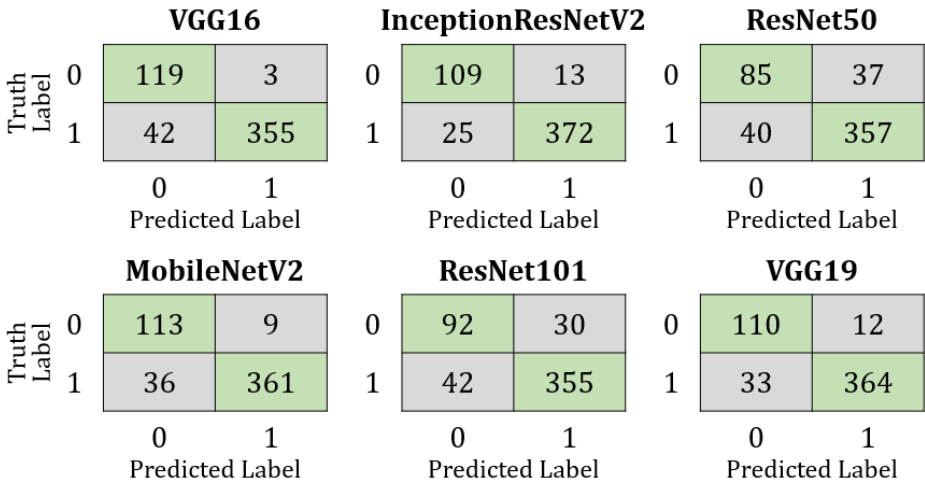
Figure 4. Confusion matrices of all models applied to the mixed test